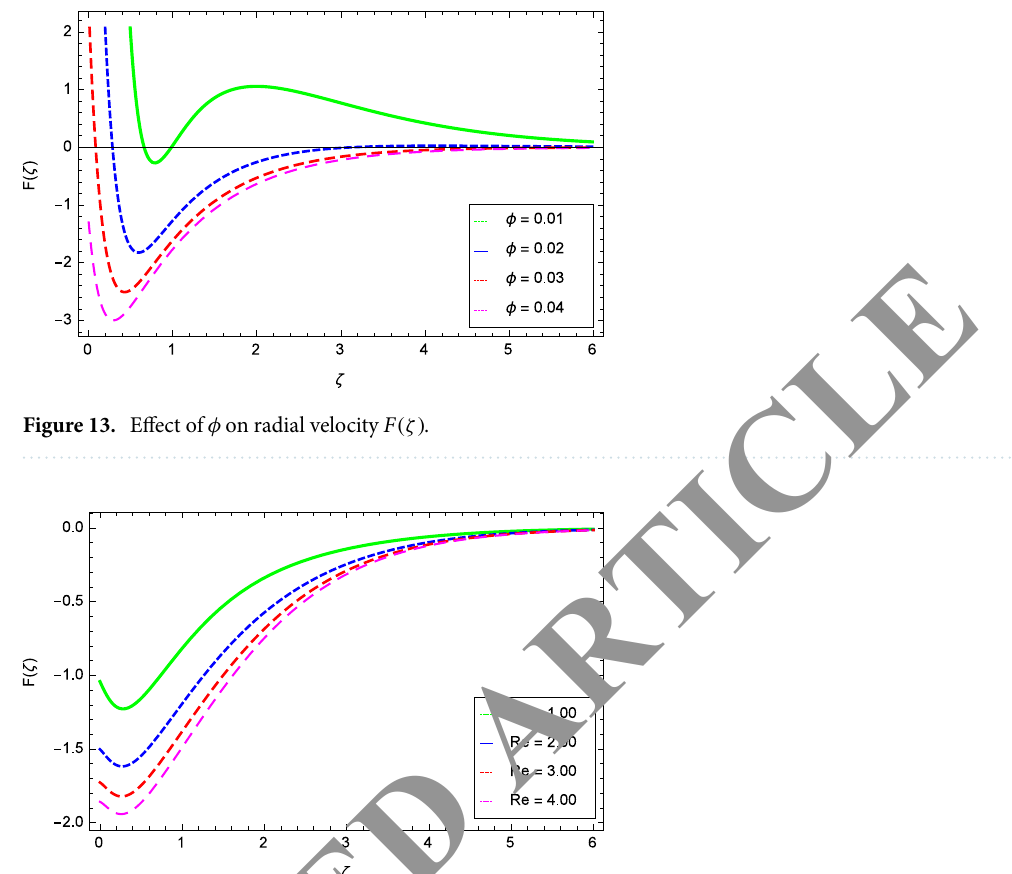
Figure 14. Effect of Re on radial velocity F (ζ) .